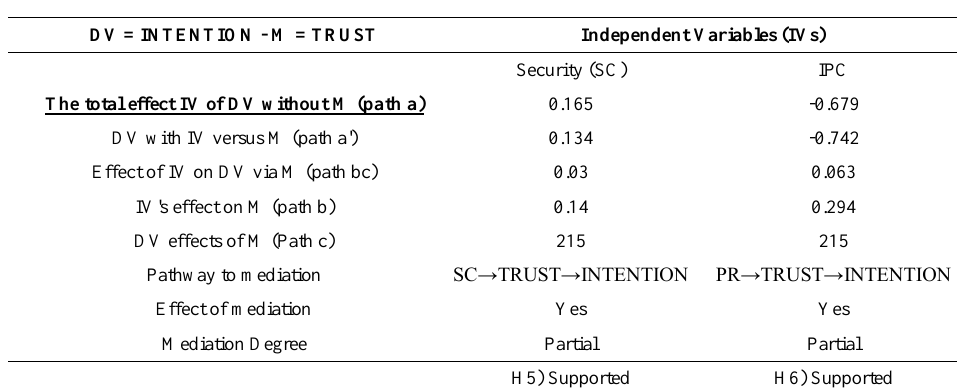
Table 4. Mediation effects of TRUST via bootstrapping: Indirect